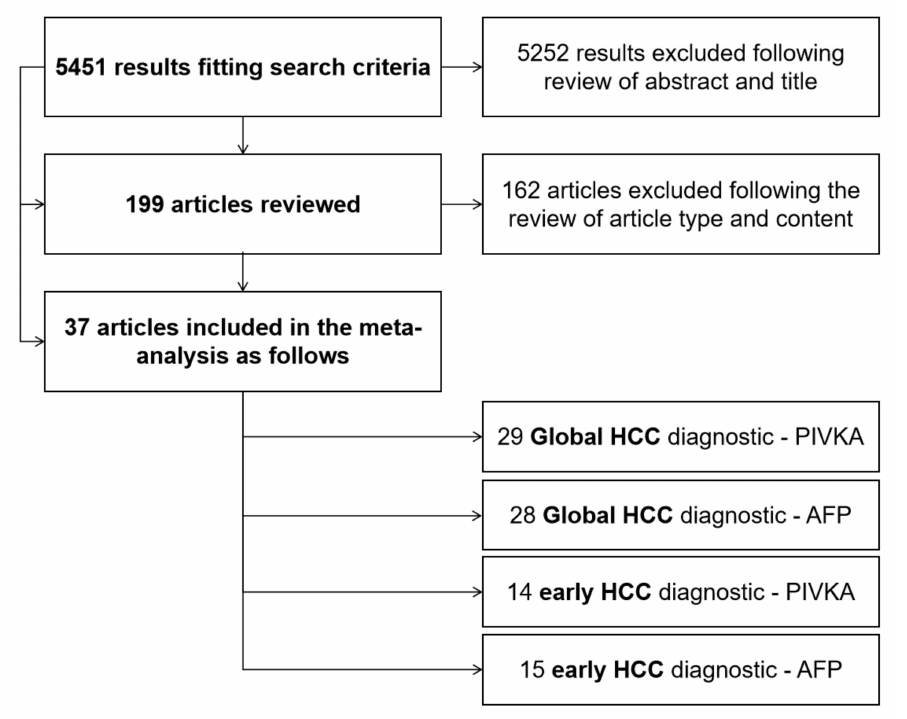
Figure 1. Flow diagram of the literature search